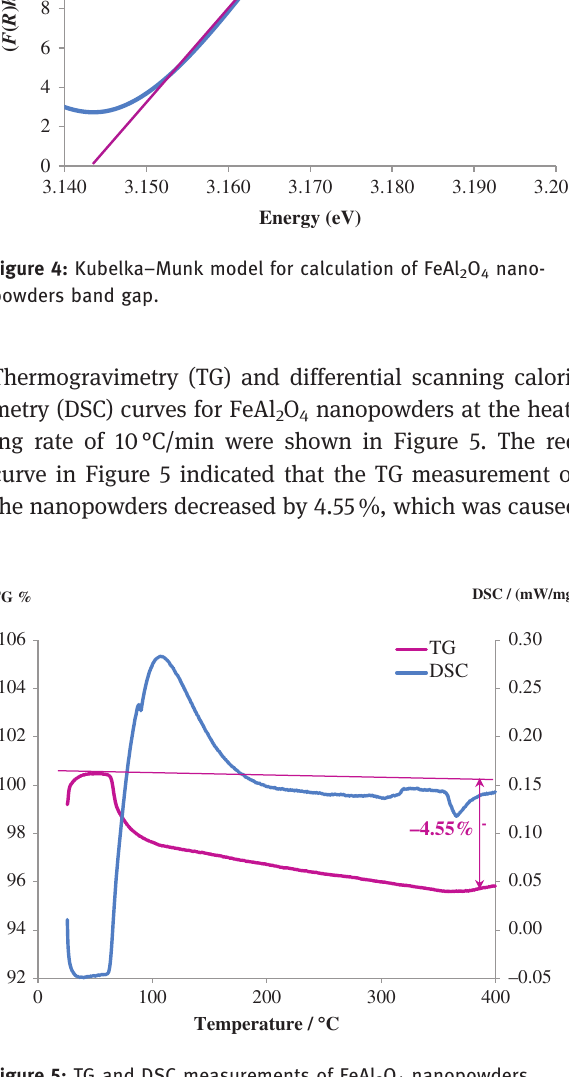
Figure 5: TG and DSC measurements of FeAl 2 O 4 nanopowders.